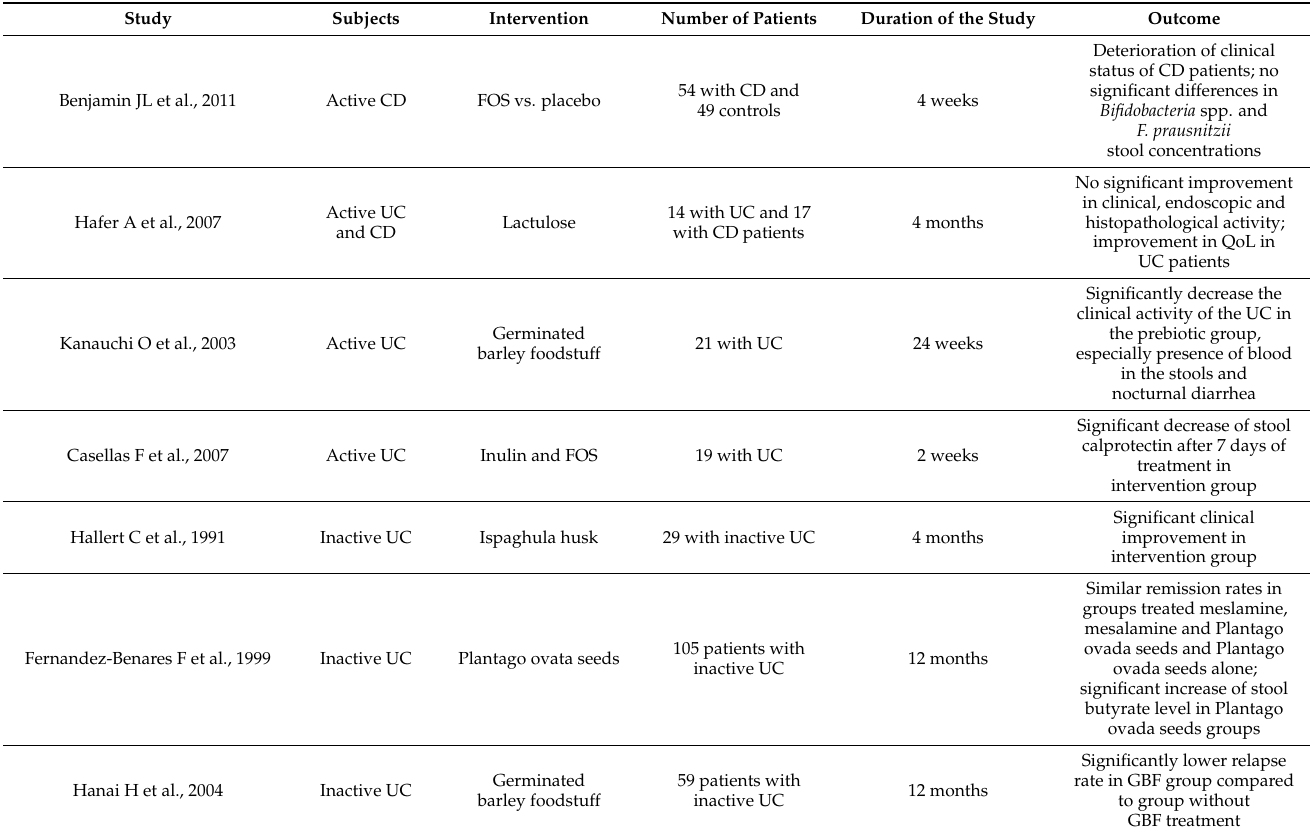
Table 1. Studies evaluating prebiotics in IBD